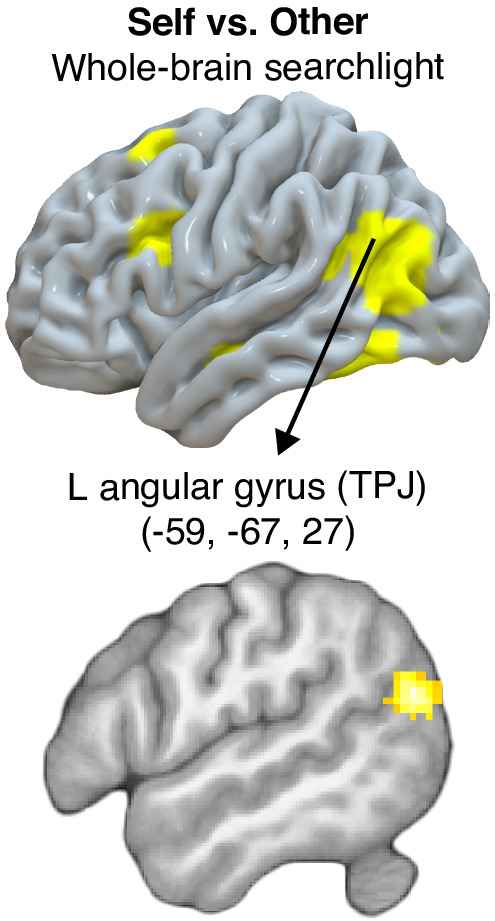
Decoding agent type at the whole-brain level.The cluster shown had the highest decoding accuracy in the whole-brain, searchlight analysis, for the self-versus-other comparison. See Supplementary file 2 for numerical details. Top: projected onto a 3D canonical brain surface. Bottom: projected onto a parasagittal section of the average structural scan generated from the 32 subjects for anatomical localization. For display purposes, the statistical threshold for the activation maps was set to p<0.001, uncorrected.